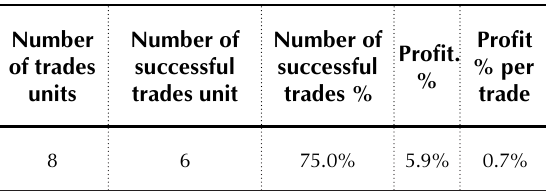
Table 8. Trading simulation results for the PFST returns over the period 1991–2018: social force